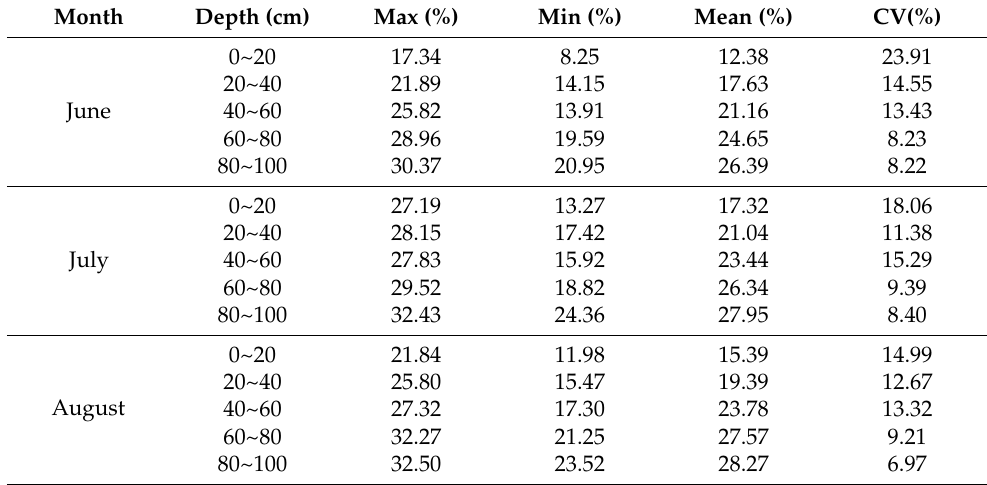
Table 1. Statistics of measured soil moisture. Note: Max, Maximum; Min, Minimum; Mean, Arith- metic mean; CV, Coefficient of